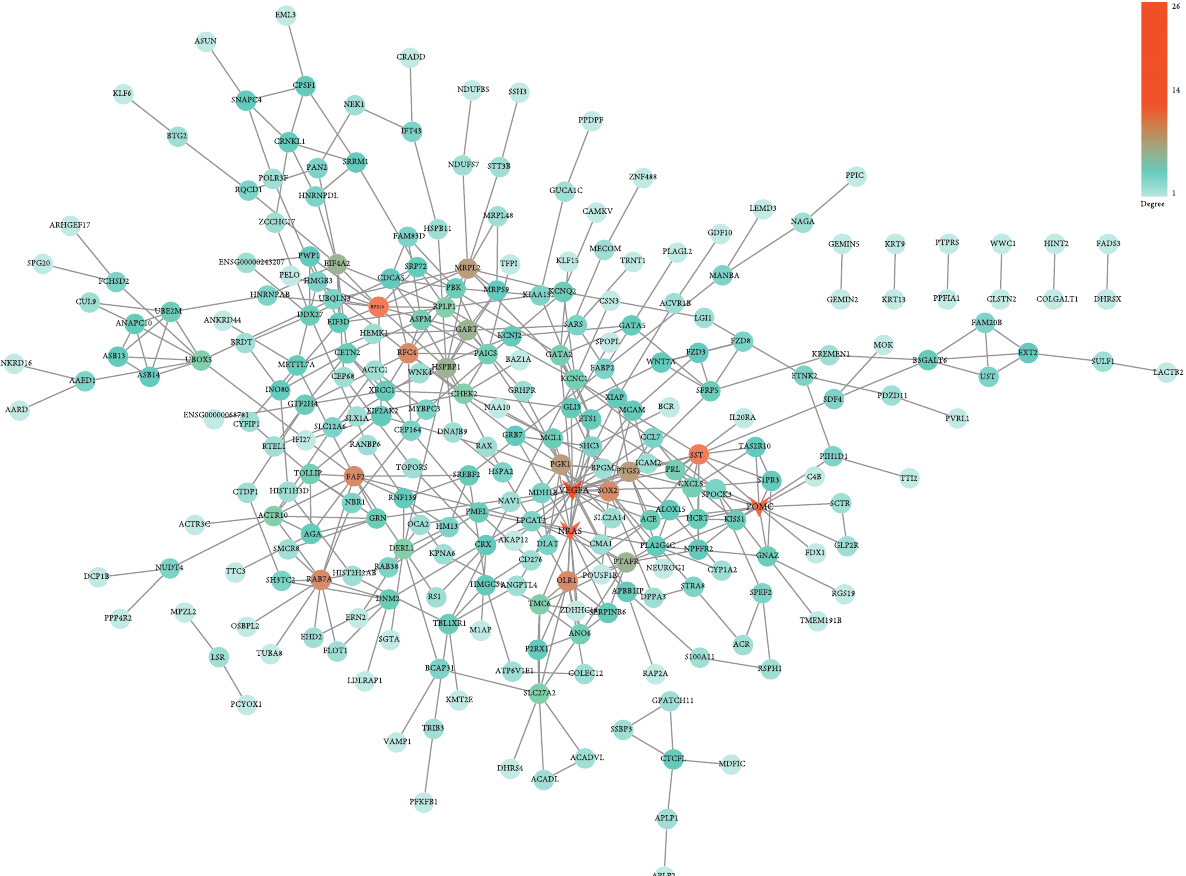
Figure 4: PPI network for upregulated DEGs. The nodes stand for the names of genes, and the edges stand for the interactions between genes. The color bar stands for the degree